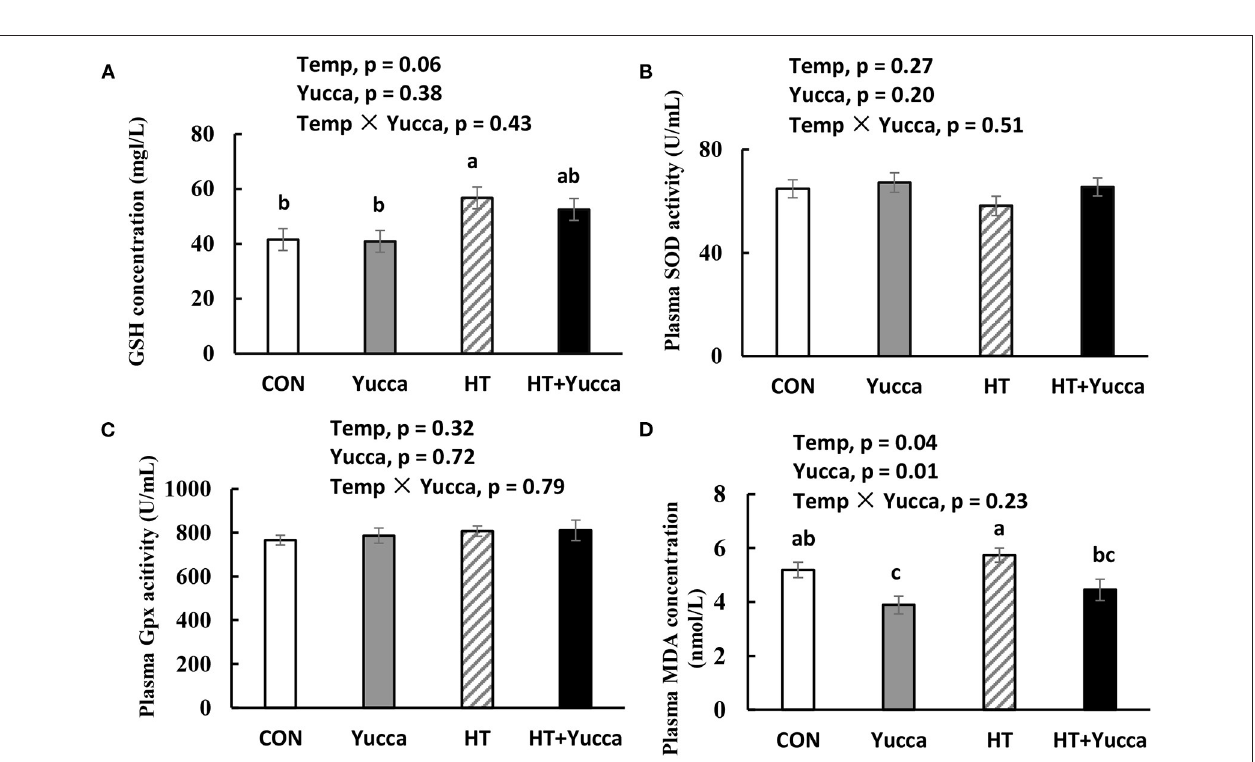
FIGURE 6 | Concentration of GSH (A) , activities of SOD (B) and Gpx (C) and concentration of MDA (D) in serum of broilers at 56 days. Broilers, at 28 days of age, were fed a basal diet and exposed to 24 ◦ C (CON) or 34 ◦ C (HT), or a basal diet supplemented with 0.1% yucca and exposed to 24 ◦ C (Yucca) or 34 ◦ C (HT + Yucca) for 4 wks. Values are means ± SE, n = 6. Means without a common letter differ, P < 0.05. Gpx, glutathione peroxidase; MDA, malondialdehyde; SOD, superoxide